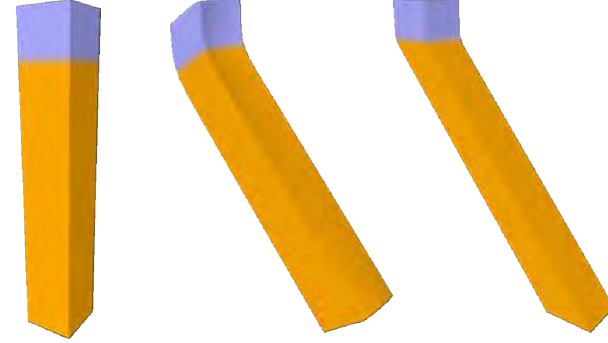
Parts of a torus (left) are elongated using anisotropic deformation gradients (middle) and ARAP deformation (right). While the deformation gradient based method exhibits a high discontinuity of triangle sizes, the deformation using anisotropic ARAP deformation is distributed more globally over the selection border.